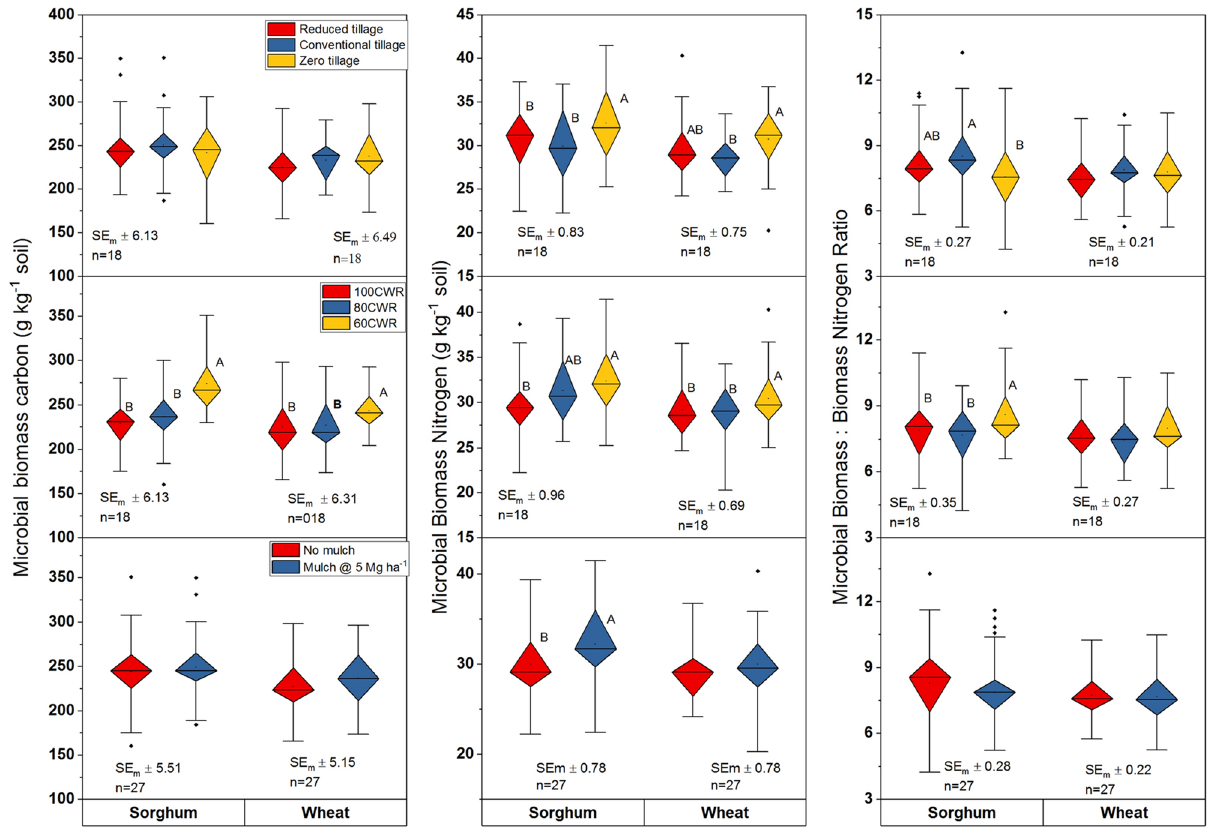
Figure 2. Influence of tillage, irrigation and mulch on dehydrogenase, alkaline phosphatase and urease activities; different uppercase letters (A, B) denote significant differences (** P < 0.01, *** P < 0.001, Tukey’s HSD test). Data are means over 2 years. Irrigation applied only in wheat, sorghum was grown as rainfed; CWR: per cent water requirement for wheat; SE m ± : standard